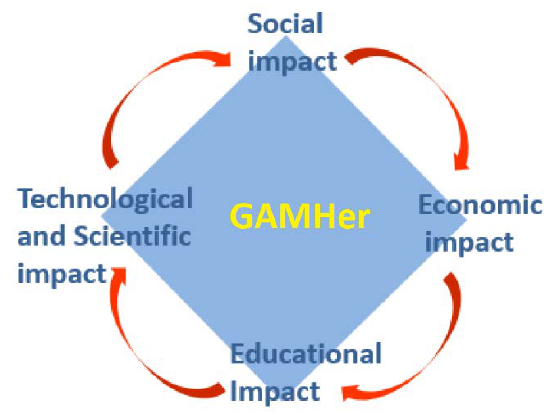
Figure 2. The impact at different levels of the GAMHer